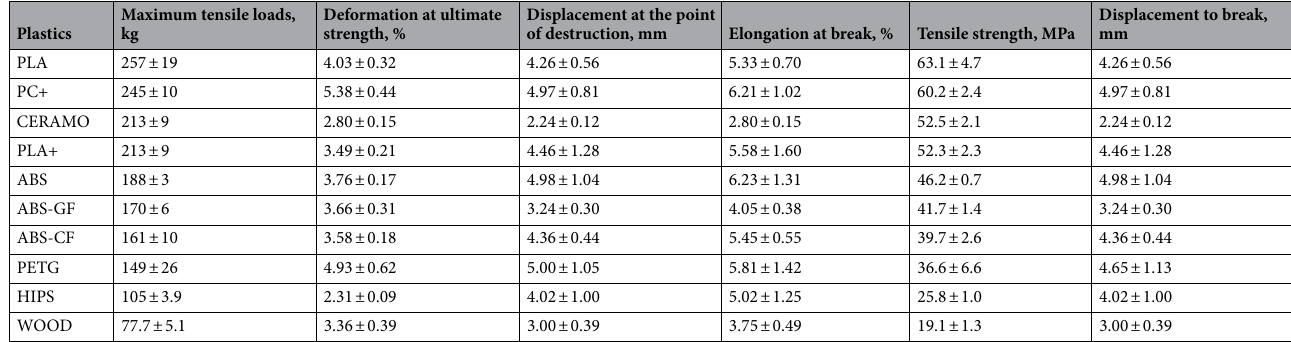
Table 1. Physical and mechanical properties of